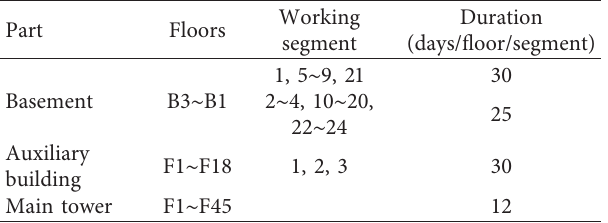
Figure 10: A schedule network of a real project. (a) Illustration of working segments: each segment is composed of several working packages and constructed floor by floor. (b) Illustration of working dependencies: there are three special nodes which are a starting point, an ending point, and a midway checkpoint. Their durations are assigned with zero day. Table 2: Schedule network failure evaluation comparison.